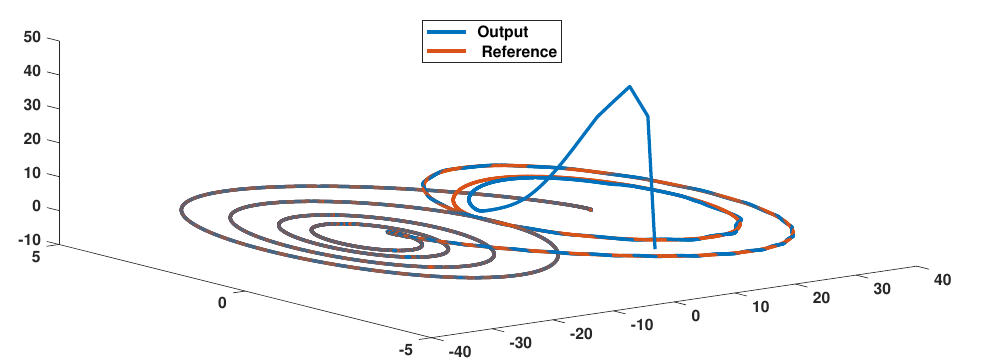
Figure 8. Example 2: Phase